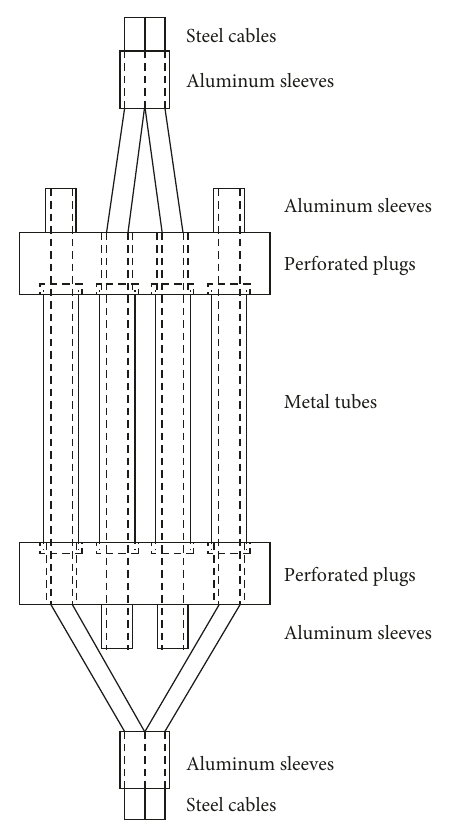
Figure 3: Scheme of the symmetric tube-crushing